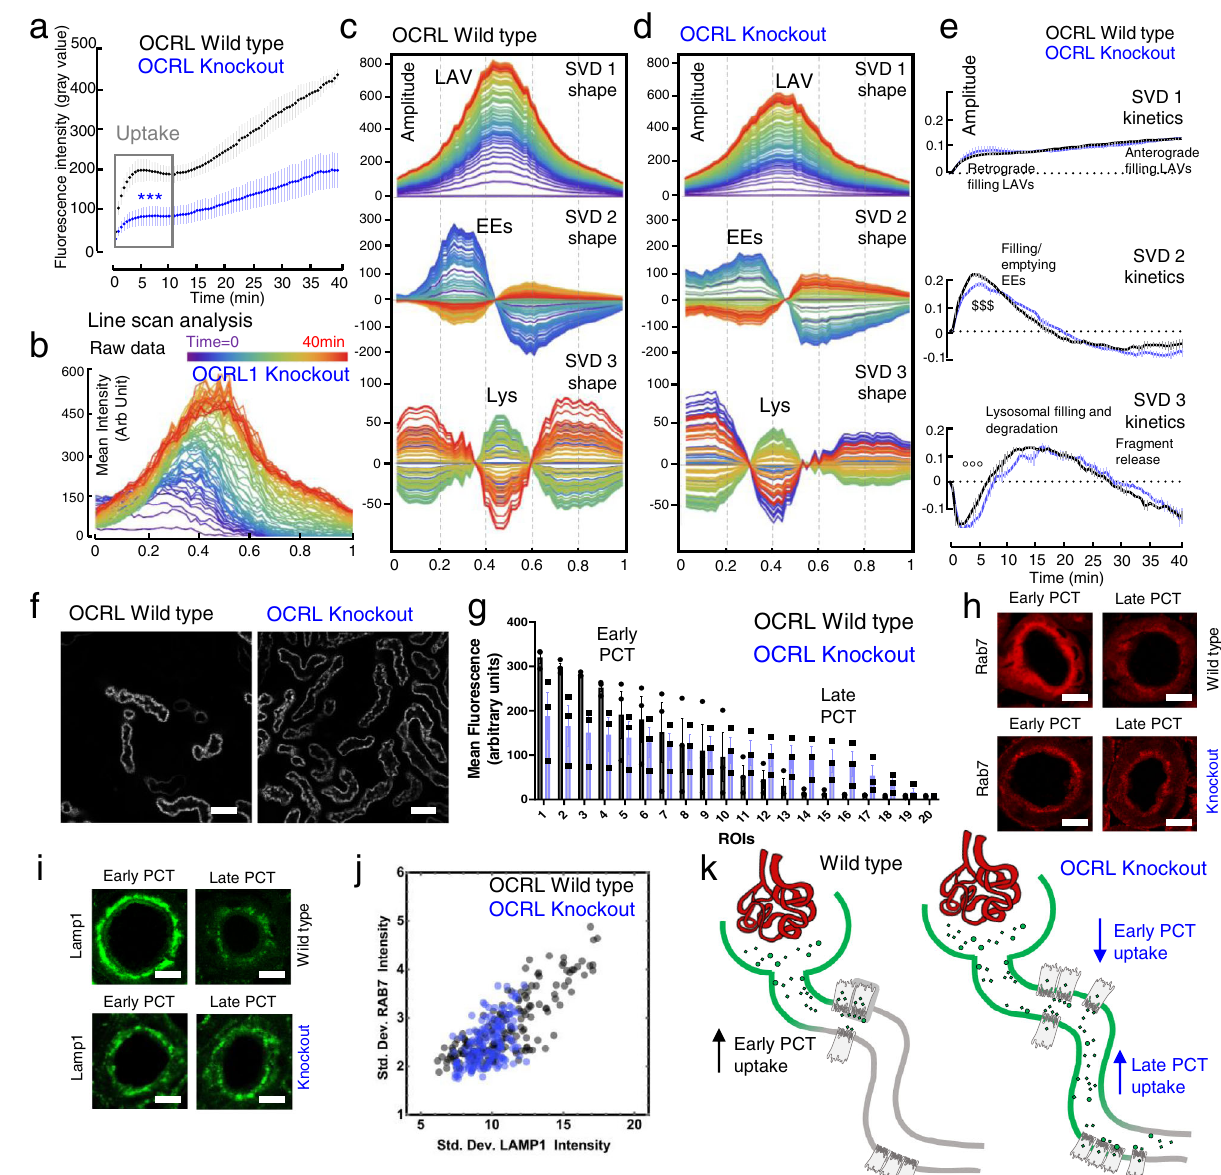
Fig. 6 | Alterations in endo-lysosomal function and compensatory remodeling in disease. a Plots depict fl uorescence intensity in S1 segments post injection of lactoglobulin At565 .UptakewasdecreasedinOCRLknockout(KO)micecomparedto wild type (WT) (mean value±SEM; time×genotype *** p <0.001; n =3 mice per group). b Normalizedraw intensitywaveformderivedfrom line scanROIsshowing intracellular evolution of fl uorescence in KO mice (0=apical, 1=basolateral). Base vectorsderivedfromSVDanalysisinwildtype( c )andKO( d ). e KineticsofSVD1-3in WT and KO mice (mean value±SEM; n =3 mice per group). SVD2 shows a small delayintransitionthroughEEs( $$$ p <0.001).SVD3(lysosomalproteindegradation)